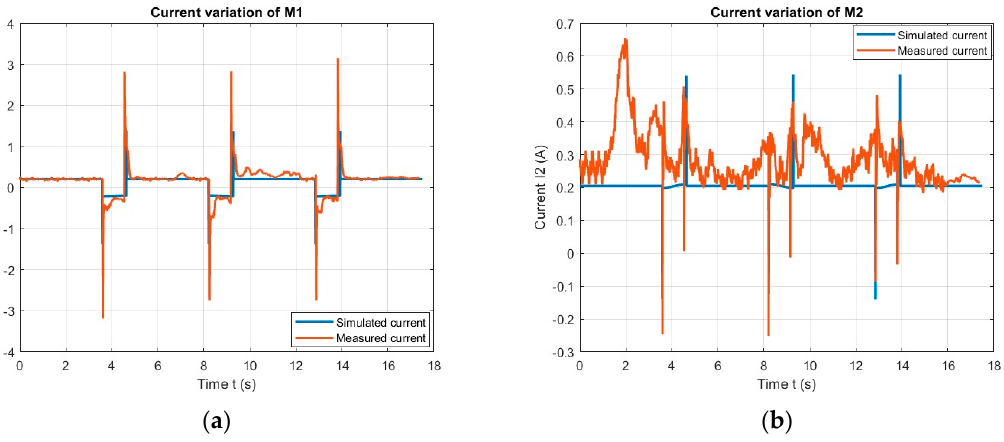
Figure 40. Variation in the simulated and measured current. ( a ) Wheel 1. ( b ) Wheel 2.